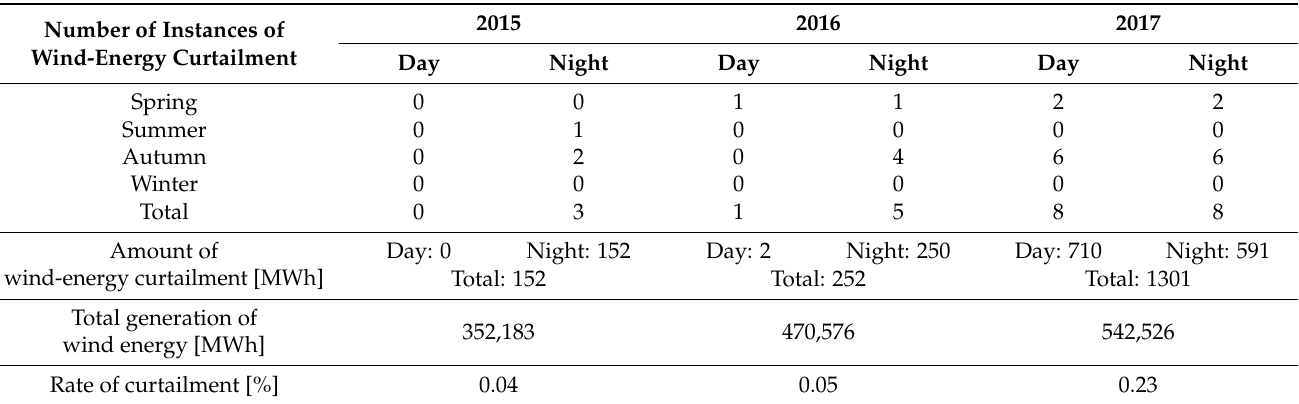
Table 2. Wind-energy curtailment in Jeju from 2015 to